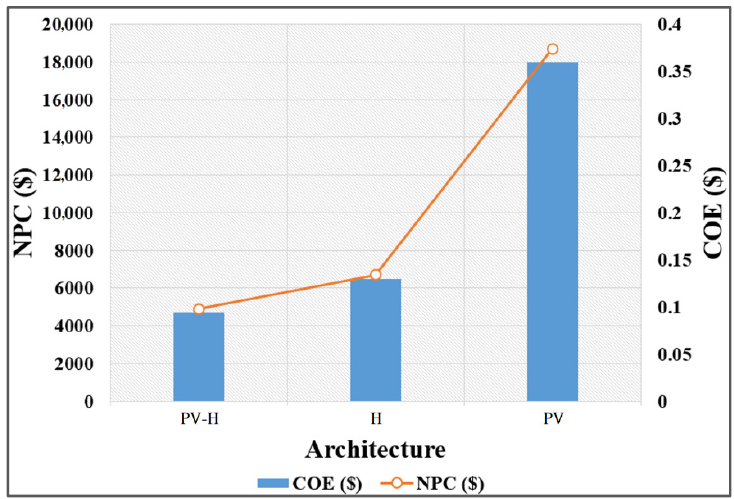
Figure 22. NPC and COE of selected architectures.